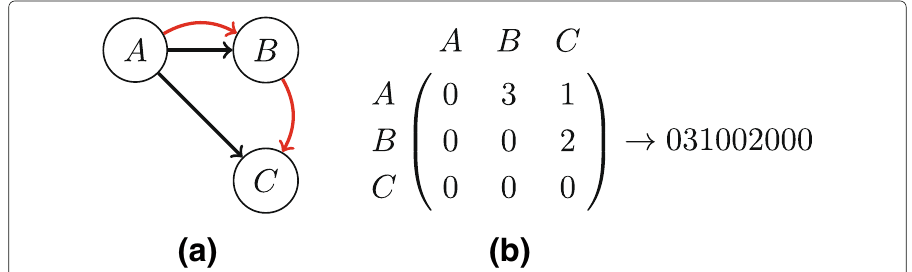
Fig. 5 Pattern labeling in directed multiplex networks. a Directed multiplex graph, b Labels of this